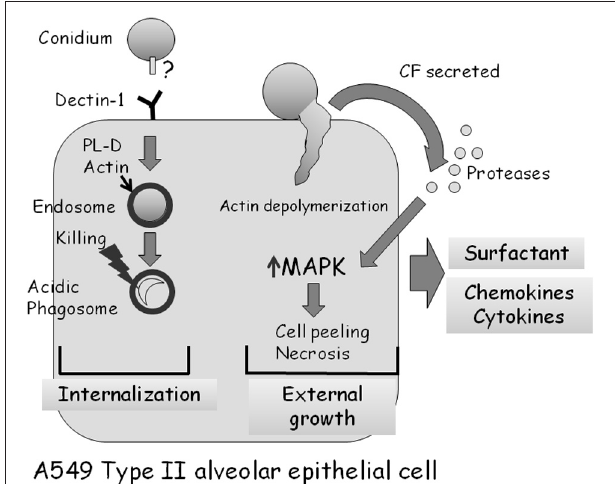
FIGURE 4 | Interaction of A. fumigatus with an A549 type II alveolar epithelial cell. Approximately 30% of adherent A. fumigatus conidia are internalized into endosomeswhich subsequently fuse to form acidic phagosomes. This process is dependent on dectin 1 receptors on the cell surface, and the phospholipase-D dependent polymerization of actin around the endosome. Most (97%) ingested conidia are killed in the acidic phagosomes after 24h. Approximately 70% of adherent A. fumigatus conidia germinate externally, causing actin cytoskeleton depolymerization and cell retraction. Proteases secreted by the fungus activate MAP-kinase signaling, leading to the production of cytokines and subsequently cell death by